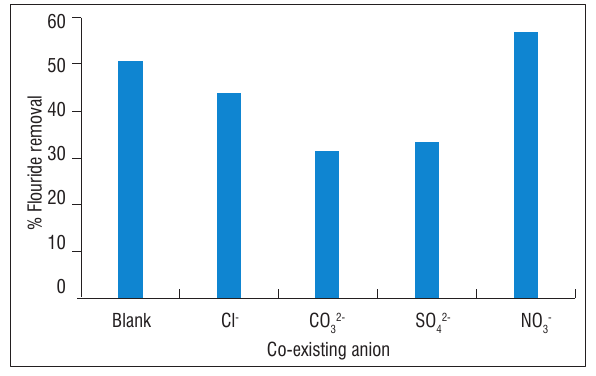
Figure 5: Effects of co-existing anions on fluoride removal by smectite- rich clay soil (at 3 mg/L fluoride, 0.8 g/100 mL adsorbent dosage and 30 min contact time at 250 rpm).